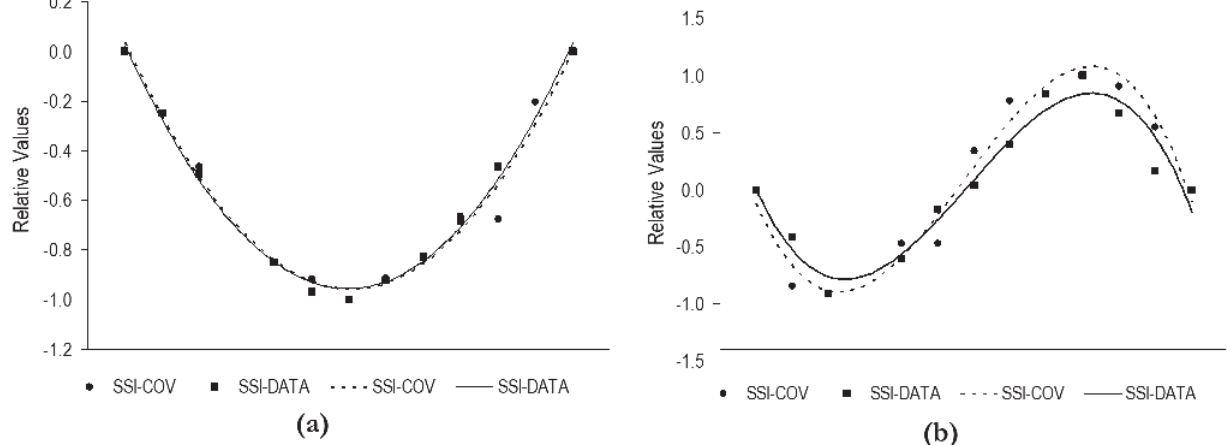
Experimental results corresponding to (a) first vertical mode shape (3.9 Hz) and to (b) second vertical mode shape (10.1 Hz), Brasiliano et al. [9]